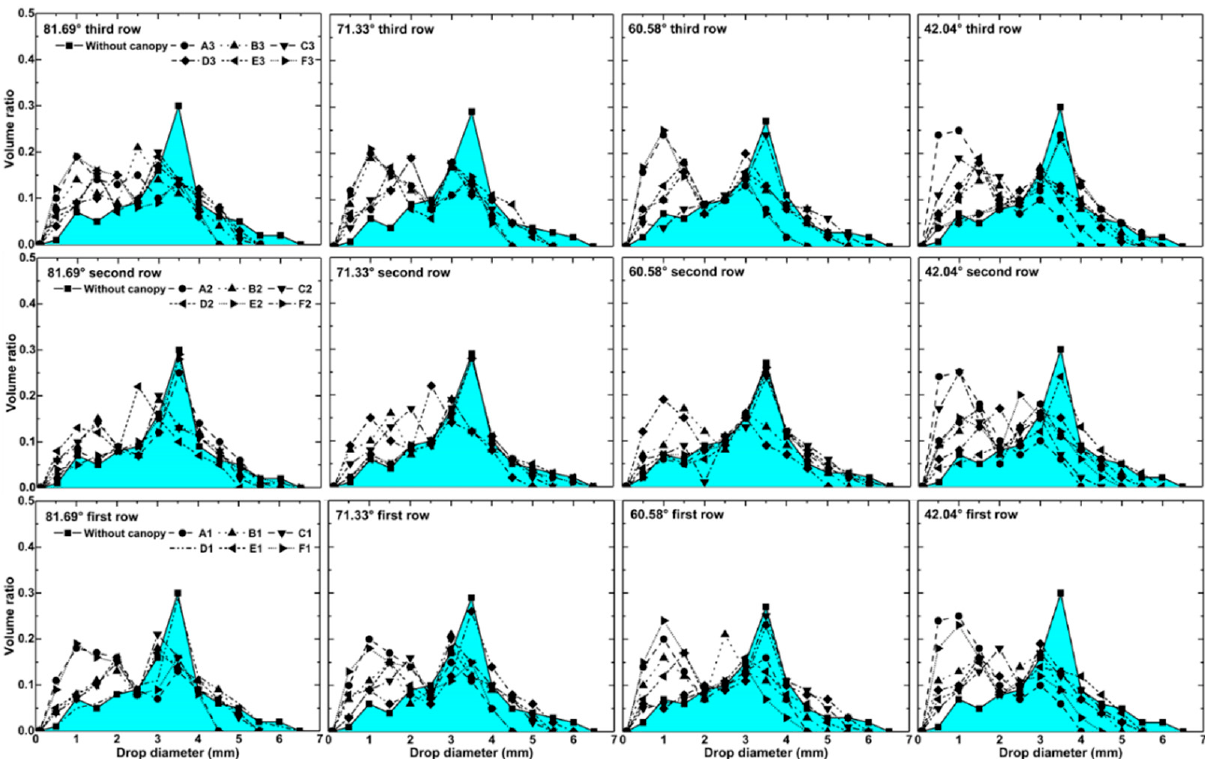
Figure 8. Spatial variation of drop size distribution of throughfall with different treatments. The filled part, shown in each subplot, is the drop size distribution for different treatments without maize crown.